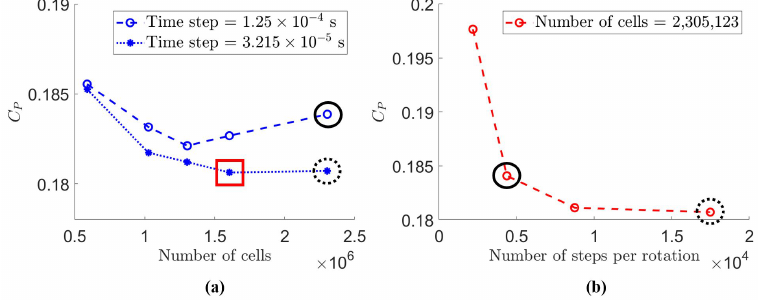
Figure 3. An iterative sensitivity analysis. The first and third steps are shown in ( a ) and the second step of the process is displayed in ( b ). The points enclosed in same style circles are equivalent on the 2 figures. The final spatial and temporal resolution used for the rest of this article is enclosed in the red